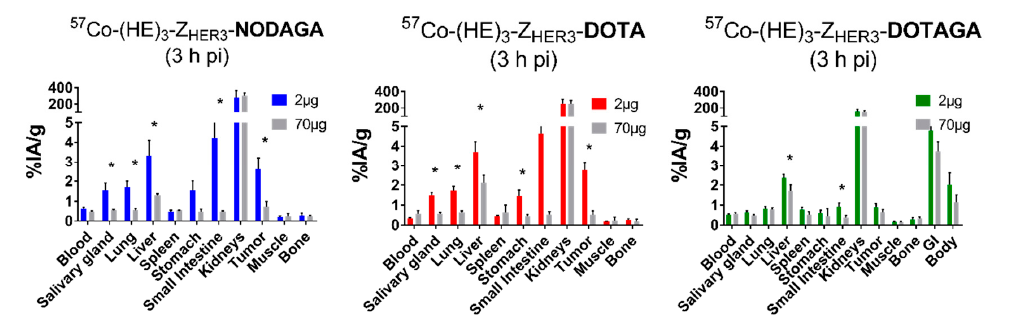
Figure 4. In vivo specificity. Tumor-bearing female Balb/c nu/nu mice were injected with 2 µg of labeled conjugates or excess amount (70 µg) of non-labeled anti-HER3 affibody molecules. Data presented as the average ± SD of n = 3–4 animals/group. * Indicates significant difference p < 0.05 between the 2 and 70 µg groups.